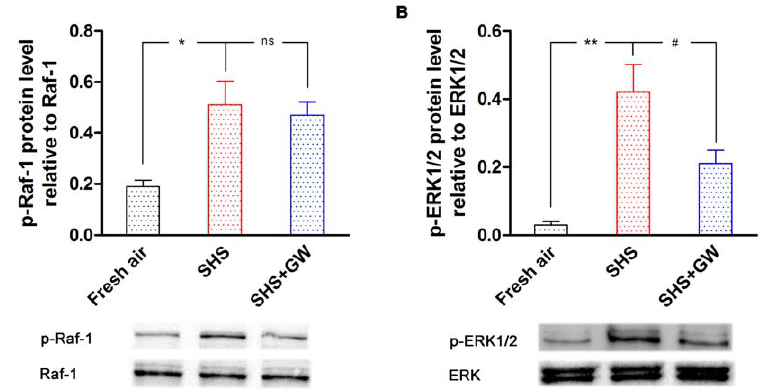
Figure 4. The activation (phosphorylation) of Raf/ERK/MAPK signaling pathway proteins. The bronchial segments were from rats that were exposed to fresh air, SHS and SHS + GW5074. The phosphorylated (p)-Raf-1 (A) and p-ERK1/2 (B) protein levels are presented relative to the total Raf-1 or total ERK1/2 level, respectively. The values are expressed as the mean 6 SEM ( n =5–6). The statistical analysis was performed using one-way ANOVA with Dunnett’s post-test. * P , 0.05, ** P , 0.01 vs. fresh air exposure group; # P , 0.05 vs. SHS exposure group; ns, not significance.